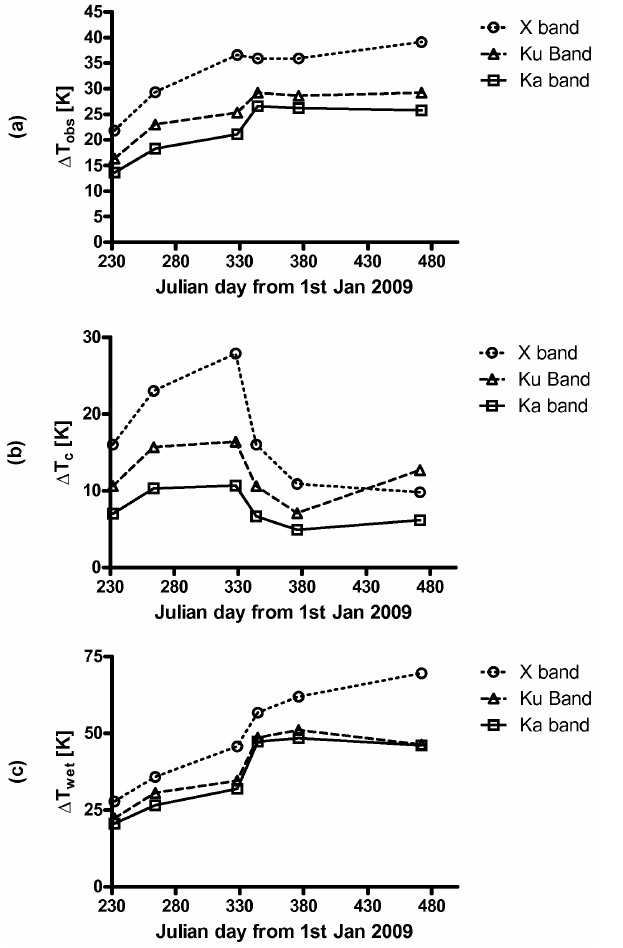
Fig. 10. ∆ T f as a function of time for the three frequencies and for three different thresholds. (a) 1 dB, (b) 1.5 dB and (c) 2 dB